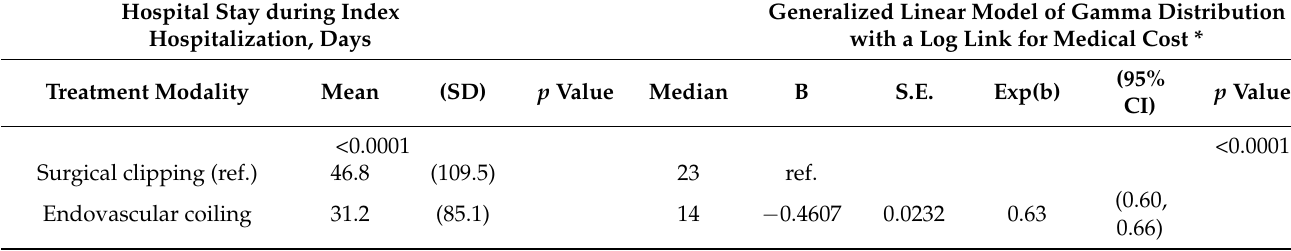
Table 2. Accumulative hospital stay during index hospitalization and medical cost stratified by aneurysm repair modalities in propensity score–matched patients with ruptured cerebral aneurysms who received surgical clipping or endovascular coiling.